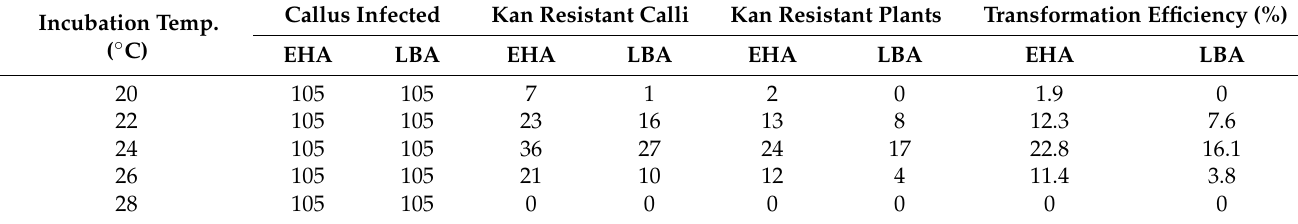
Table A8. Effect of incubation temperature on transformation efficiency of callus derived from seeds of P. scrobiculatum L. Incubation